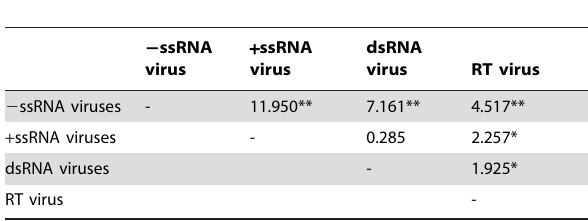
Table 5. Pair-wised variance analysis the GC contents between viral